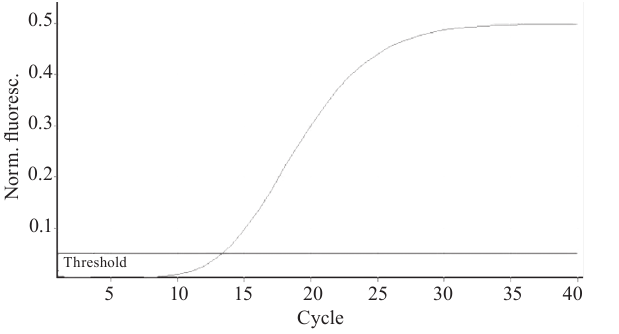
(а) Chicken meat DNA, Yellow (b) ICS, Figure 1 Specificity assessment of the chicken identification methodology